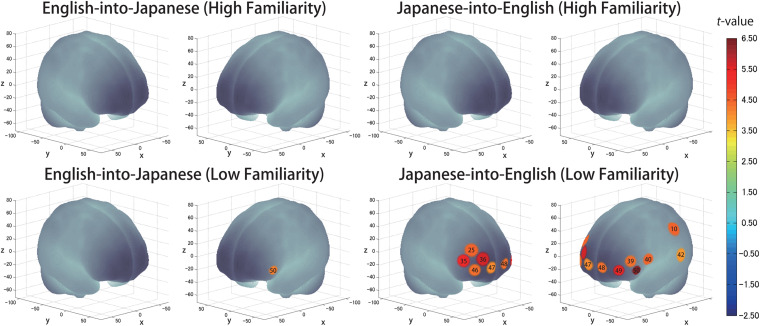
The results of the group analysis for the advanced group. Family wise errors due to multichannel measurement were corrected using the Bonferroni method. Significant t-values for MNI-registered channels are indicated by the color scale.